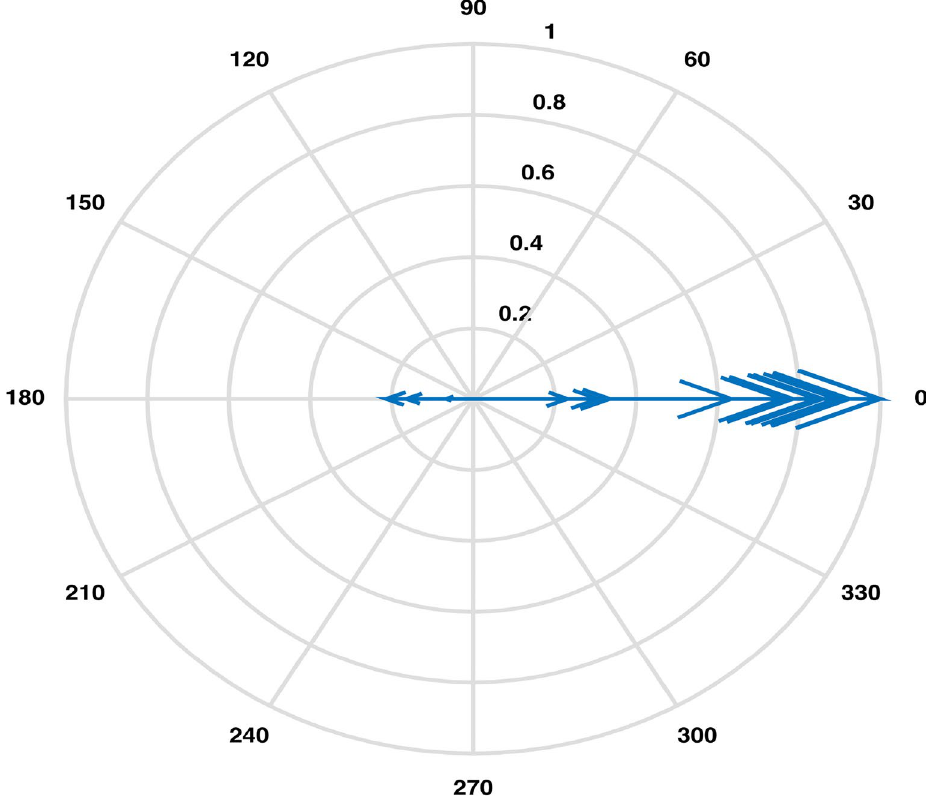
Figure 6. Pairwise correlations of TDS with other